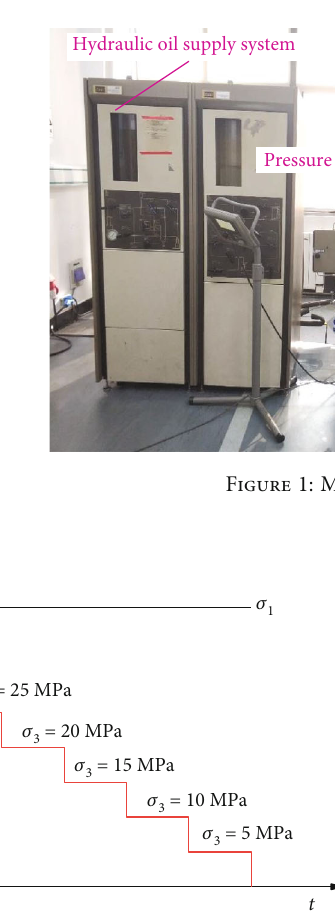
Figure 2: Variety of stress during step by step unloading creep.